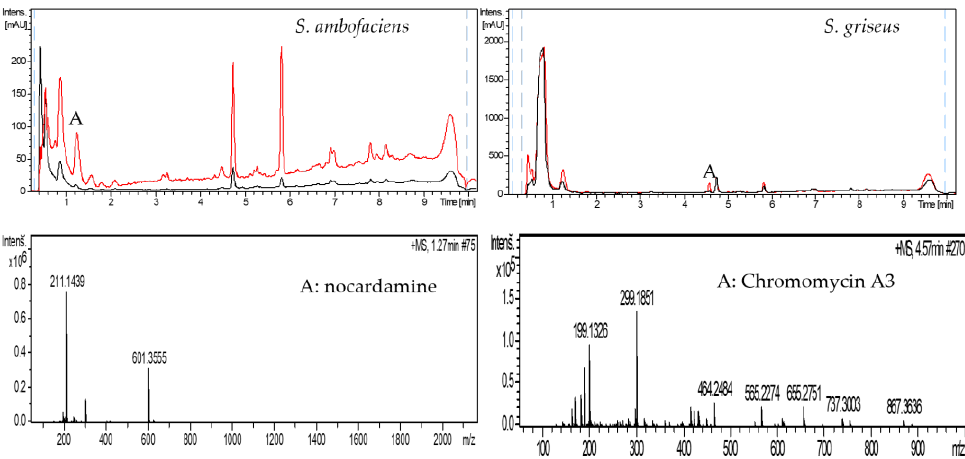
Figure 3. Analysis of the metabolites produced by S. ambofaciens ( left ) and by S. griseus subsp. griseus ( right ) grown in YEPD with water (black) or with SAP (red). Mass spectra of compounds in the differential peaks.